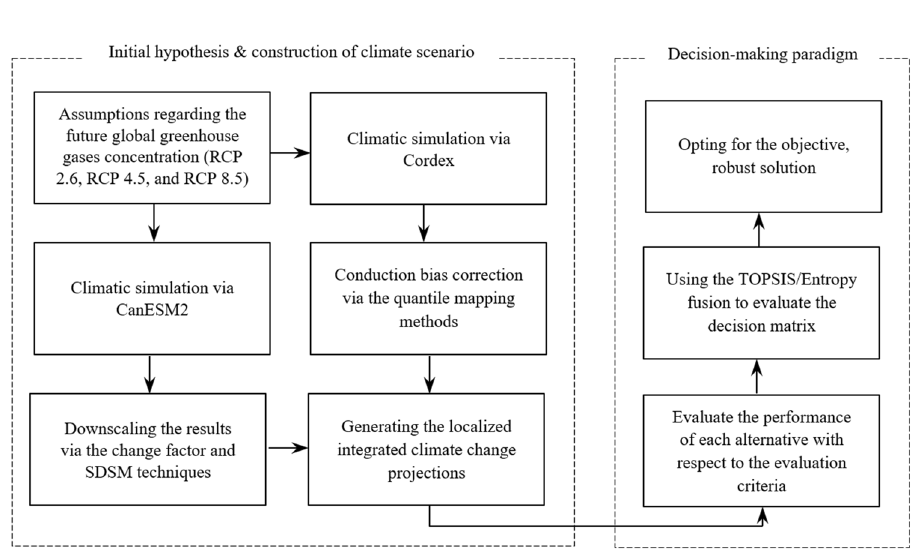
Figure 3. Flowchart of the proposed